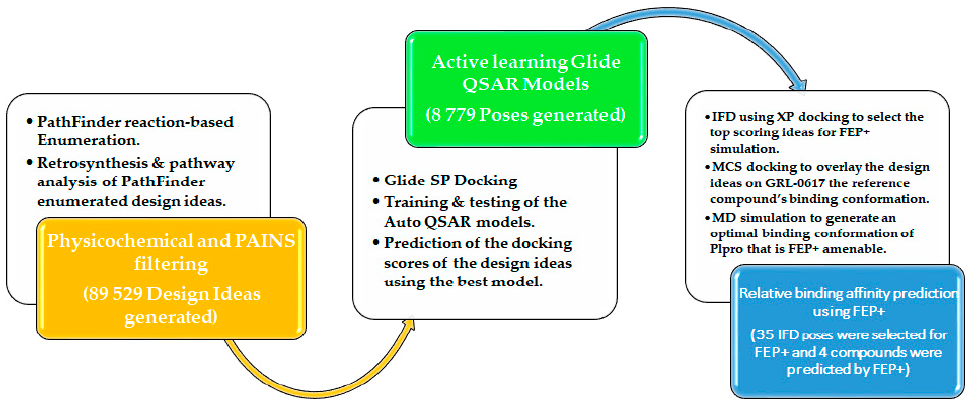
Figure 2. Pathfinder-driven reaction-based enumeration, active learning Glide QSAR modeling, IFD, and FEP+ screening workflow.